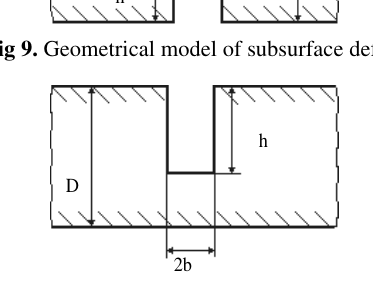
Fig 10. Geometrical model of surface defect